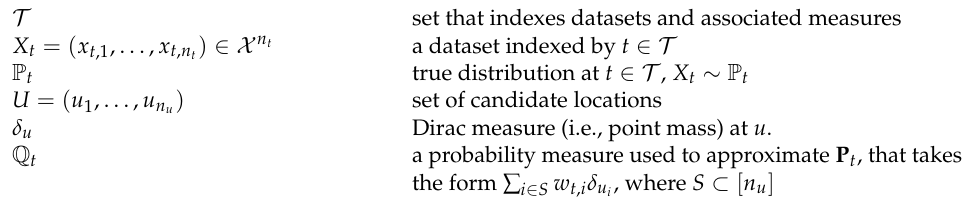
Table 1. Notation used in this